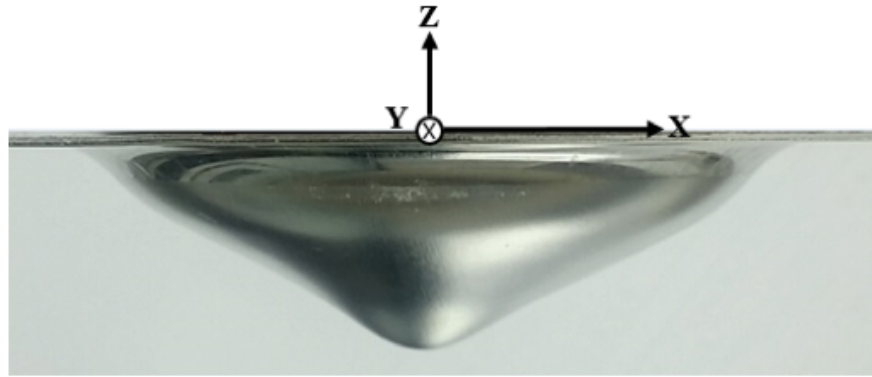
Figure 14. Deformed sheet after the free bulge test.